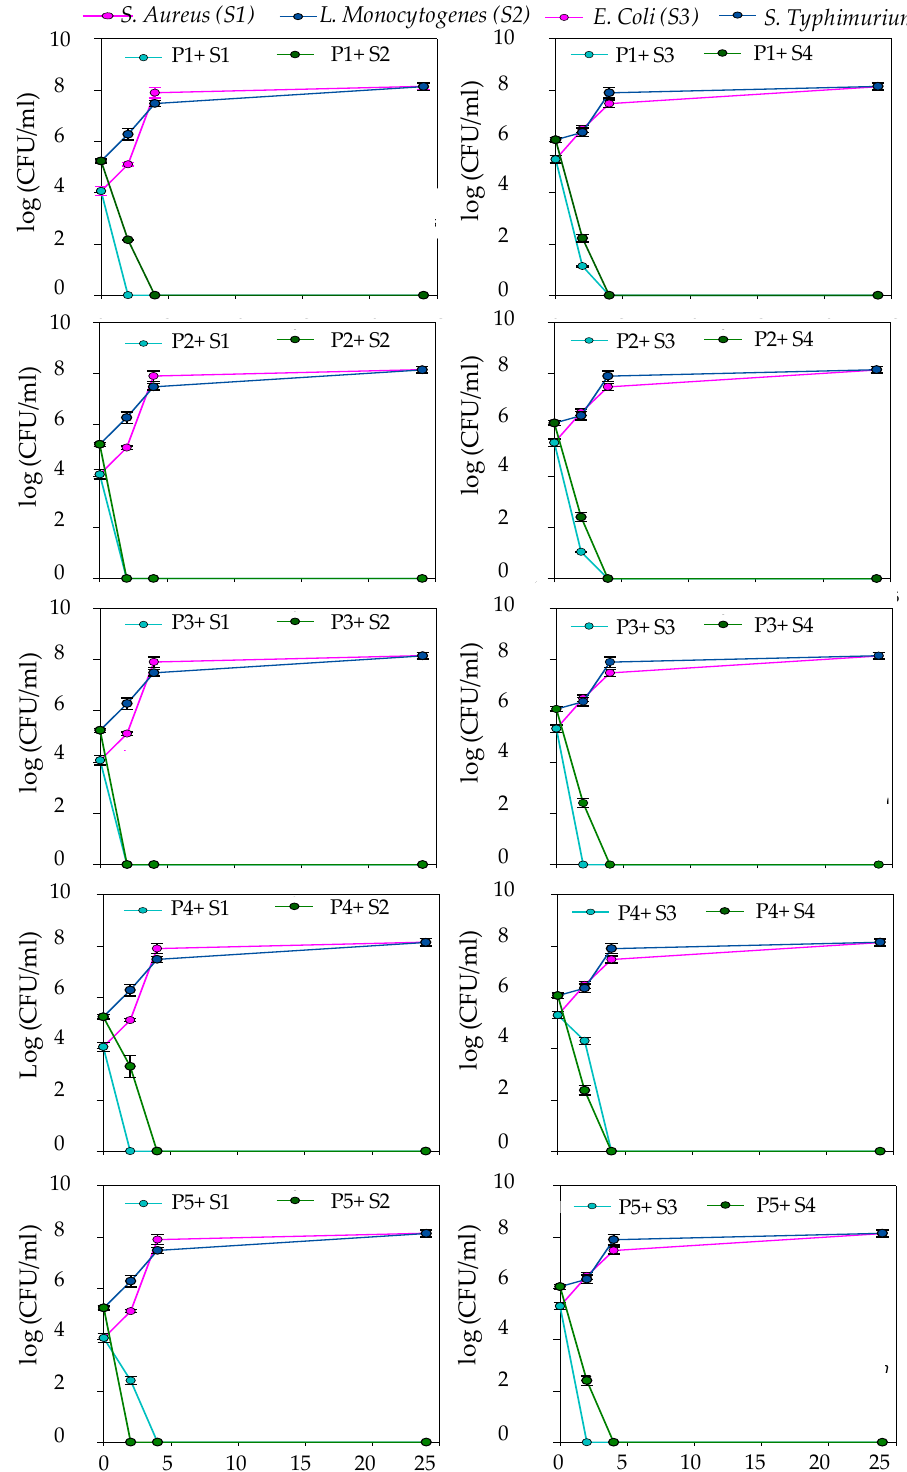
Figure 2. Time-kill curves of Gram-negative in the left ( Escherichia coli (S2) and Salmonella typhimurium (S4) ) and Gram-positive in the right ( Listeria monocytogenes (S2) and Staphylococcus aureus (S1) ) in control suspensions and the MICs of P1 (Pistacia lentiscus ), P2 (Rosmarinus officinalis ), P3 (Erica multiflora ), P4 (Calicotome villosa ) and P5 (Phillyrea latifolia ) ethanolic extracts. The mean of the standard deviations for three replicates is indicated by symbols. The lower detection threshold was 0